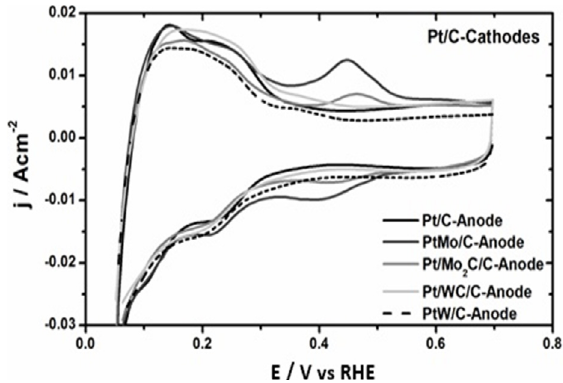
Figure 11 - Cyclic voltammograms obtained at 25 o C for the various Pt/C cathodes recorded after 5000 voltage AST cycles of the corresponding anodes in the potential window of 0.1 to 0.8 V vs RHE. For these measurements, the cathodes were supplied with Ar and the anodes with pure H 2